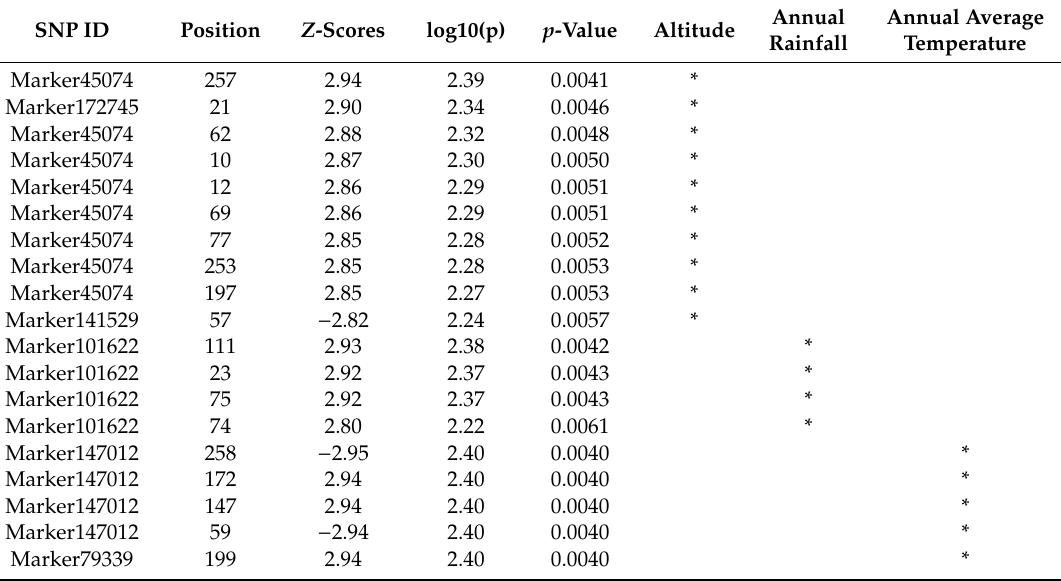
Table 7. A summary of putative adaptive markers displaying associations with di ff erent climate variables identified by LFMM